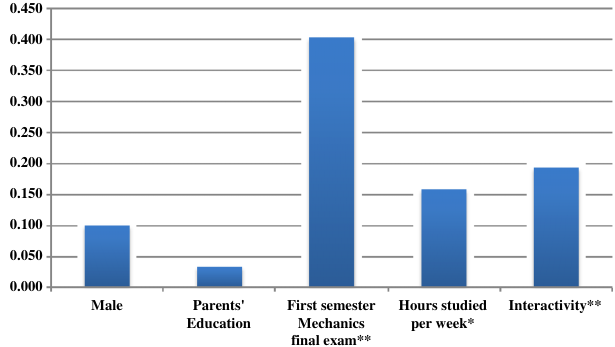
FIG. 3 (color online). Standardized coefficients for model 3 with Mechanics common final exam problem score as the dependent variable (from Table V) (* p < 0 : 05 , ** p < 0 : 01 ).